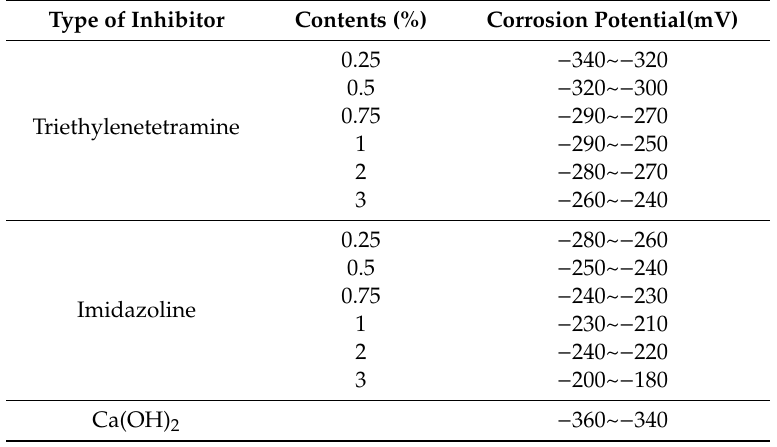
Table 2. Corrosion potentials of steel bars.